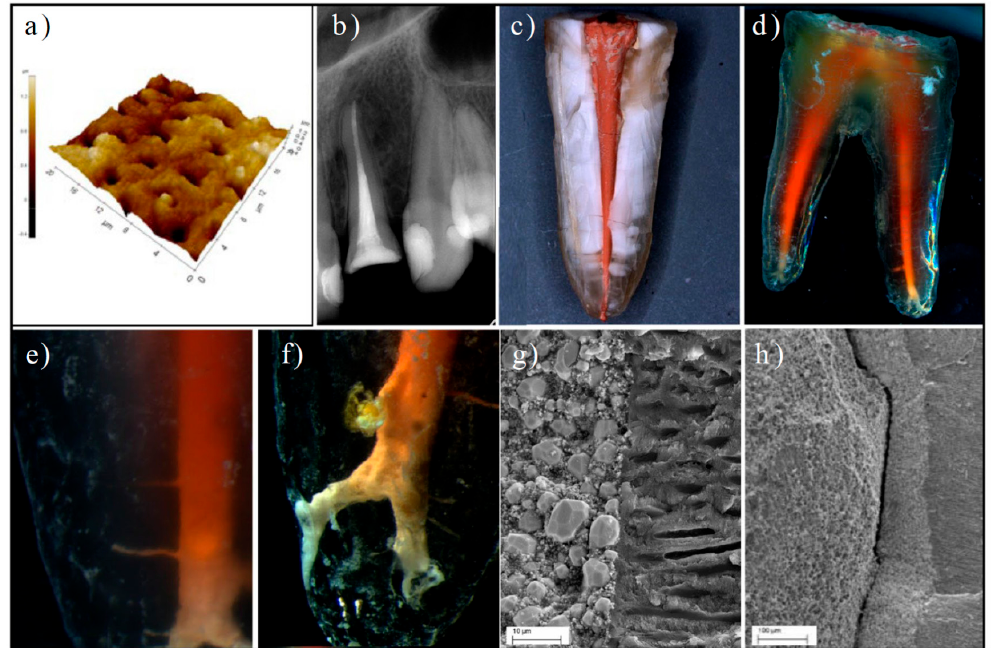
Figure 12. Examples of endodontically treated teeth: ( a ) morphology of the transverse fracture of the canal dentin (atomic force microscope); ( b – g ) root canal filled with gutta-percha material with AH Plus sealant by the thermoplastic method: ( b ) X-ray of the patient; ( c ) longitudinal fracture of the tooth; ( d – f ) decalcified teeth; ( e ) filling the side branches of the main canal; ( f ) root delta (( c – f ) Stereo Discovery stereo light microscope with AxioCam HRC digital camera by Zeiss at 8–50× magnification); ( g ) tight connection of the root canal with the material based on gutta-percha and sealant in all sections of the root canal; ( h ) after an incorrectly performed procedure, border of three layers, tightly connected dentine of the root canal with a thick intermediate layer of sealant and a leak between the sealant and the material on the gutta-percha matrix covered with a sealant layer (( g , h )— scanning electron microscope).